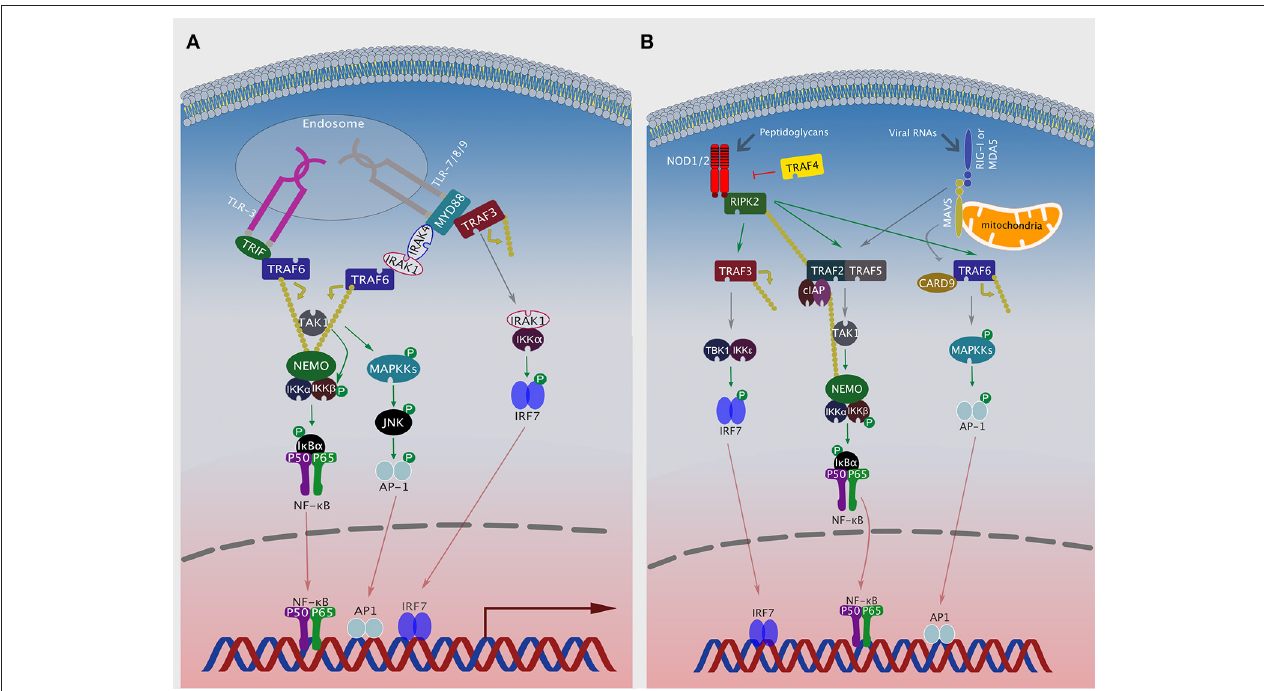
FIGURE 2 | TRAFs in NLR and RLR signaling pathways. (A) After ligand recognition, endosomal TLRs recruit TRAF6, either via TRIF (TLR3) or via MyD88/IRAK1/IRAK4 (TLR7, 8 or 9) to activate NF- κ B. Additionally, TLR 7, 8, or 9 can recruit MyD88, TRAF3, IRAK1, and IKK α to activate IRF7. (B) Ligand activated NOD1 or NOD2 associate with RIPK2, which can then recruit either TRAF3 to activate the TBK1/IKK ε /IRF7 axis, TRAF2, and TRAF5 to activate NF- κ B or TRAF6 and CARD9 to activate MAPK signaling. Viral RNAs activate RIG-I or MDA5, which then associate with the mitochondrial protein MAVS and activate NF- κ B or MAPK signaling by recruiting TRAF2/5 or TRAF6/CARD9,